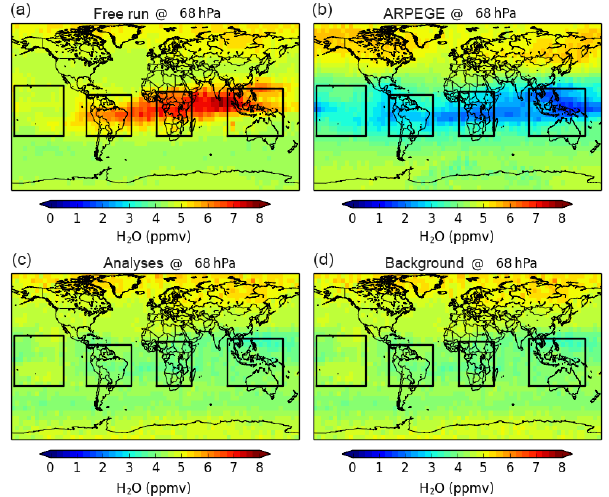
Figure 15. Monthly averaged H 2 O fields at 68hPa in January 2012 in the MIPAS observation space (in time and space coinci- dence with MIPAS observations) from the free run (MOCAGE, a ), ARPEGE (b) , MLS analyses (assimilation, c ) and the back- ground (d)